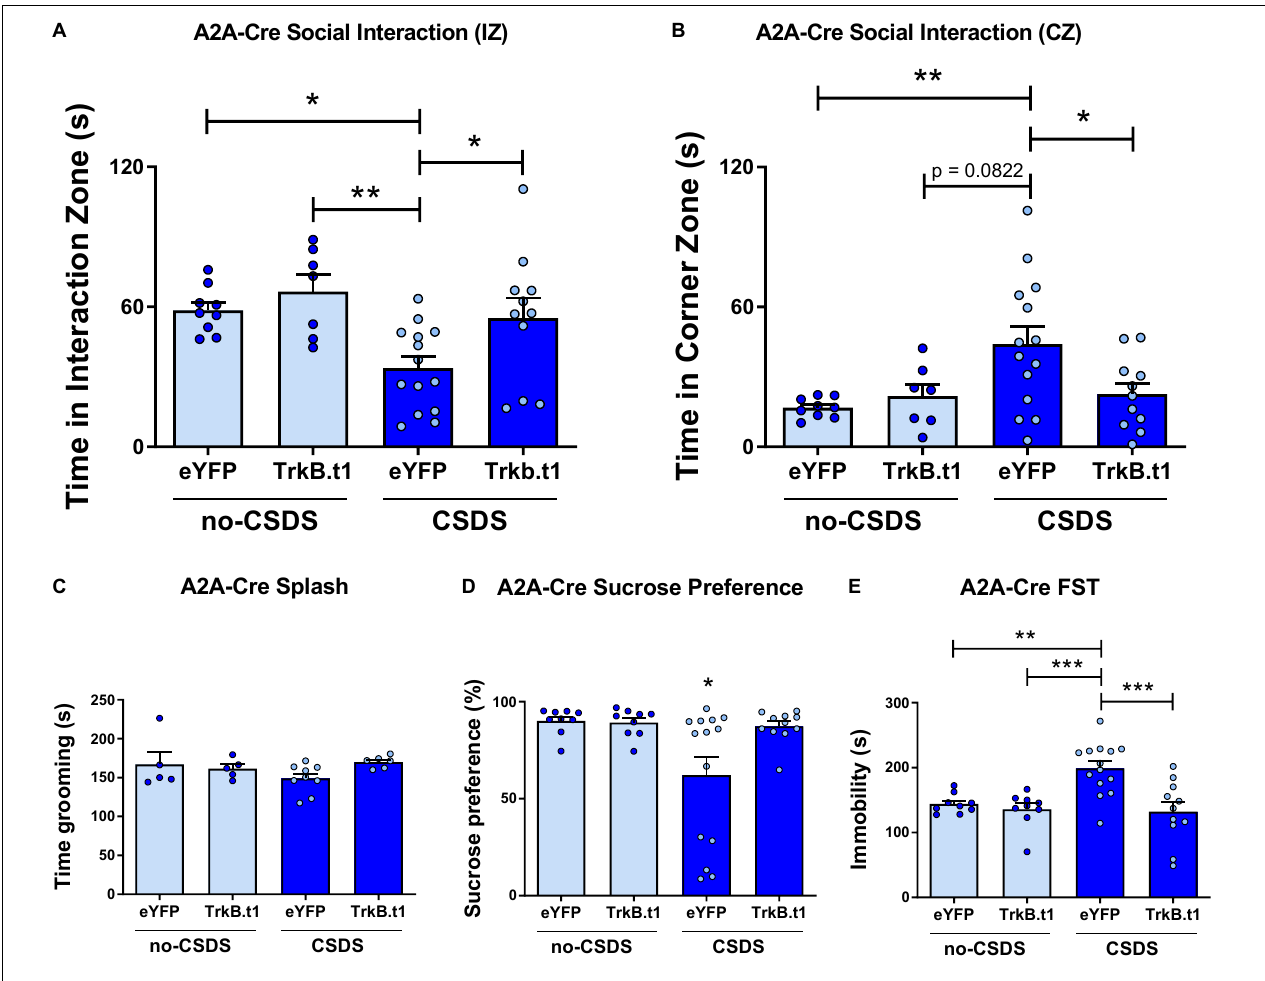
FIGURE 3 | Blocking BDNF-TrkB signaling in D2-MSNs induces a resilient phenotype after 10 days of chronic social defeat stress (CSDS) in male mice. (A) CSDS-eYFP group spent less time interacting with the social target (target session), a behavior prevented by TrkB.t1 expression in D2-MSNs ( N = 7–14). (B) CSDS-eYFP group spent more time avoiding social interaction with the social target (target session), which was also prevented by TrkB.t1 expression in D2-MSNs ( N = 7–14). (C) Total time spent in grooming during the sucrose splash test was not significant across groups ( N = 5–7). (D,E) TrkB.t1 expression